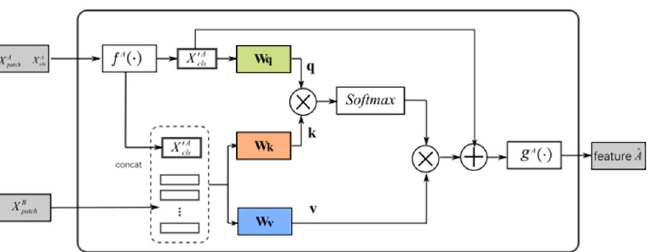
Fig 3. Cross-attention module for feature A branch. The CLS token of feature A serves as a query token to interact with the patch tokens from feature B through attention. f A ( � ) and g A ( � ) are linear projection functions for dimension